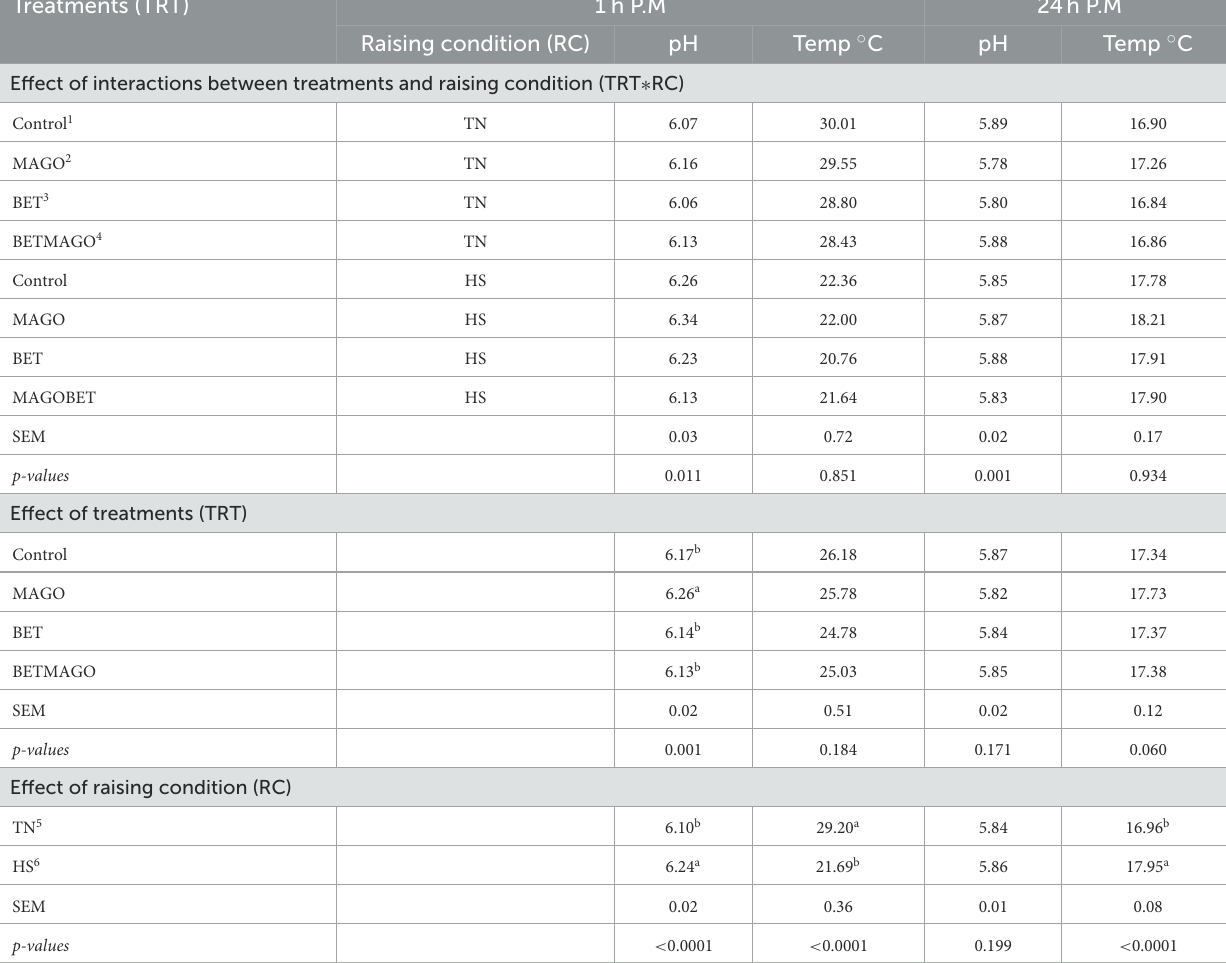
The initial and final meat color derivatives of breast